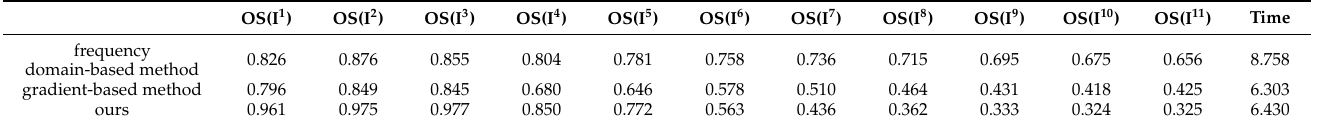
Table 2. The calculation result of the foreground score value of the focus